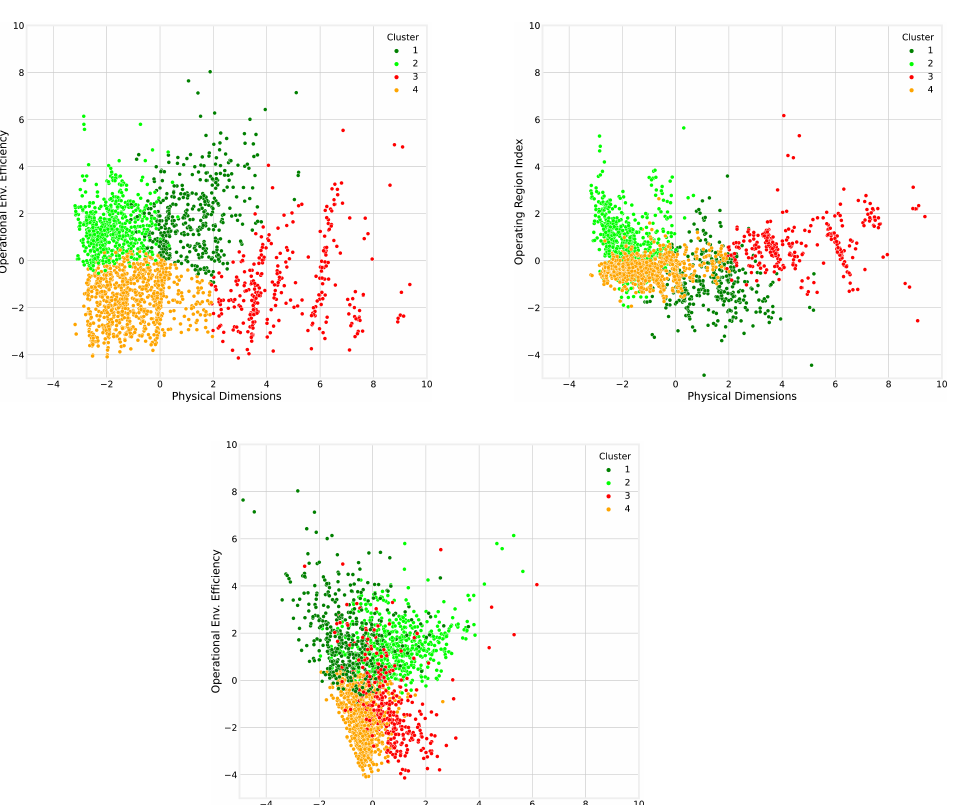
Figure 11. The four clusters (colored dark green, light green, red, and orange) are defined by the k-means algorithm plotted with respect to the PCs. Upper left plot: clusters on the plane defined by first and second PCs. Upper right plot: clusters on the plane defined by first and third PCs. Lower plot: clusters on the plane defined by second and third PCs.